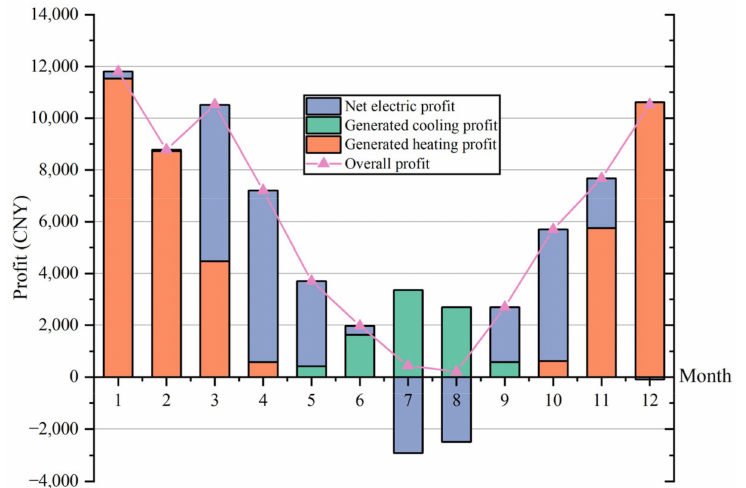
Figure 18. Monthly economic profit and cost of